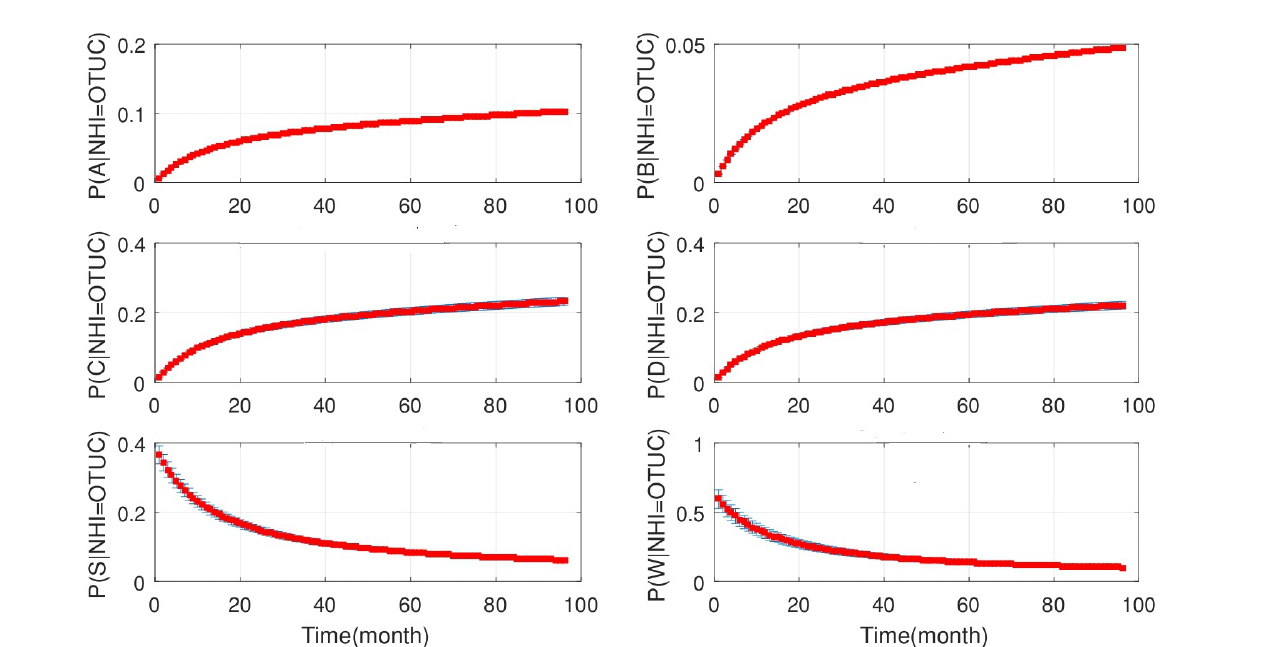
Figure 7. The probabilities of all the root nodes (A is the age of cattle, B is the badger density, C is the manure storage, D is the stock density, S is the silage fed and W is the number of purchased cattle) when new evidence which is officially TB free status unclassified (OTUC) is added to the network continuously from 2008 to 2015 (bottom-up inference for